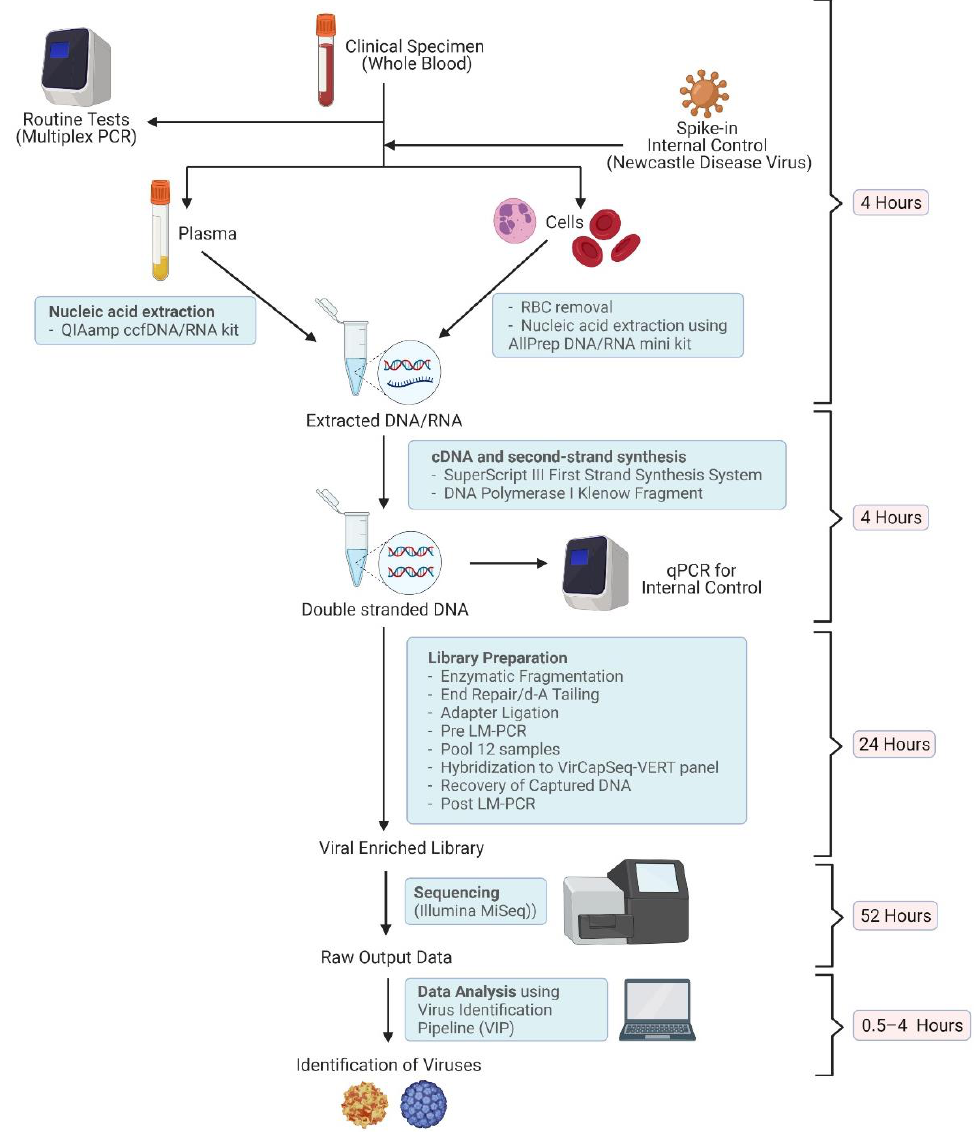
Figure 1. A schematic diagram of the virus detection procedure used in this study. Equipment and kits used, and the time consumed at each step are shown (Created with BioRender.com, accessed on 5 April 2022).